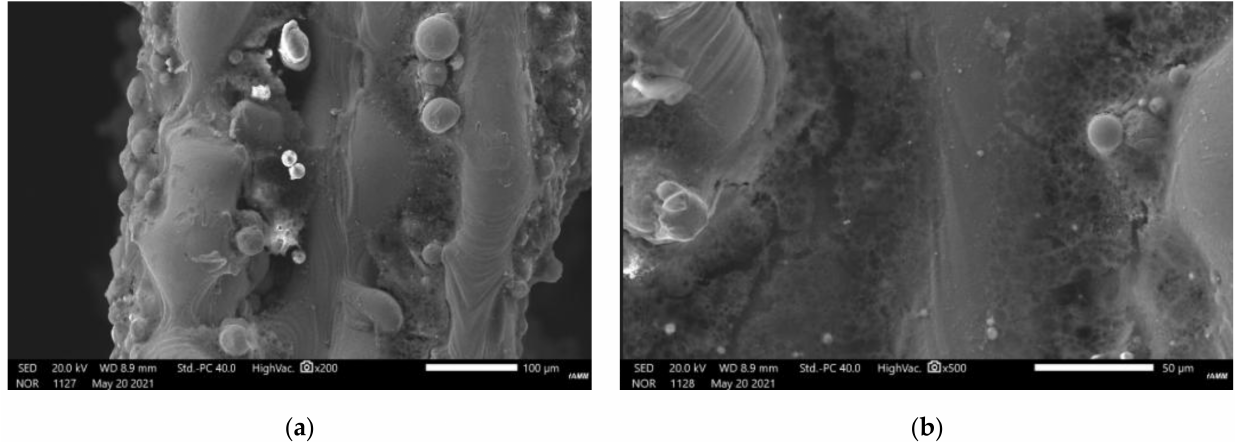
Figure 13. SEM of porous stainless-steel part after substrate and material preheating: ( a ) × 200. ( b ) ×